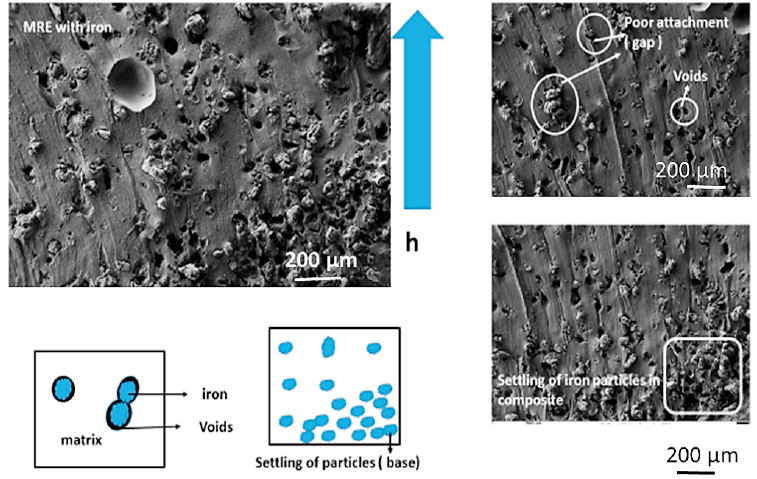
Figure 15. MRE with iron particles distribution and some exceptions during fabrication.